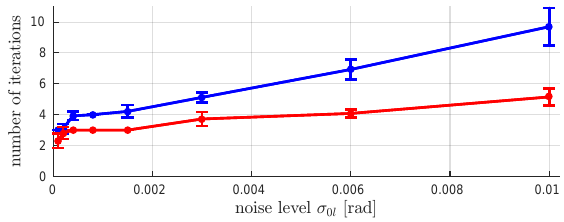
Figure 5. The number of iterations needed to achieve convergence at different noise level σ 0 l and moderate relative precision of σ 0 x = 0 . 001 when using T c = 0 . 001 (blue line) or T c = 0 . 1 (red